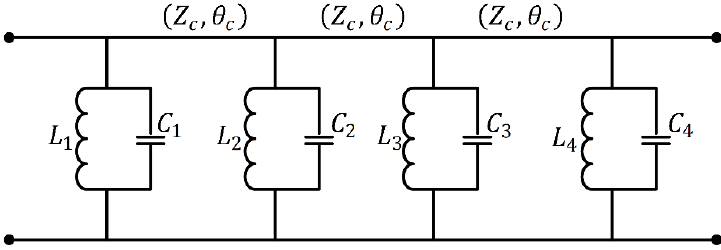
Figure 5. Modified UWB bandpass filter structure with TTL short-circuited stubs of length θ s and tapered impedance Z 012 = Z 042 and Z 032 = Z 022 .